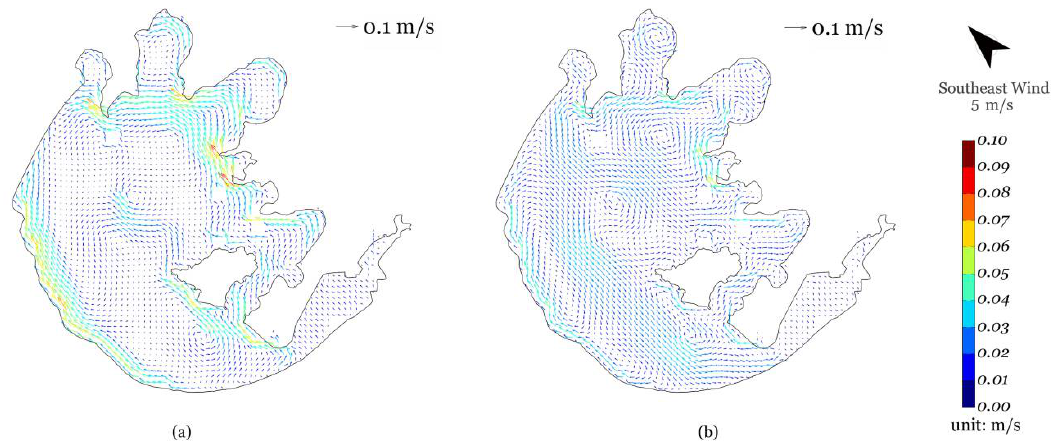
Figure 7. Surface and bottom horizontal hydrodynamic circulation pattern with southeast wind, with ( a ) the surface layer velocity field, ( b ) the bottom layer velocity field.